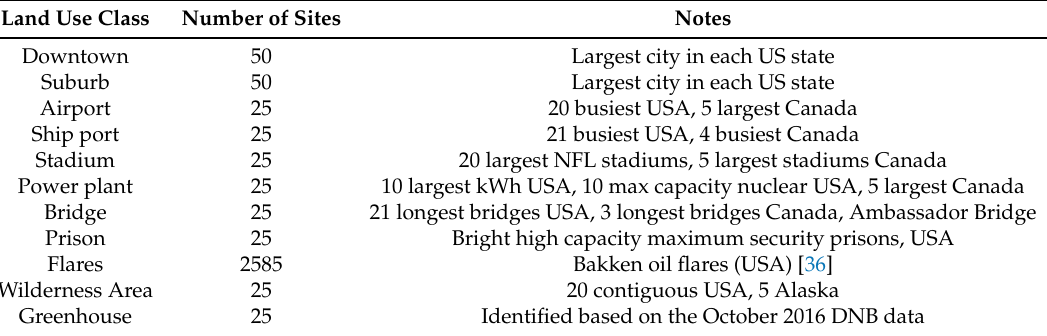
Table 1. Light emission classes and number of sites examined for each land use